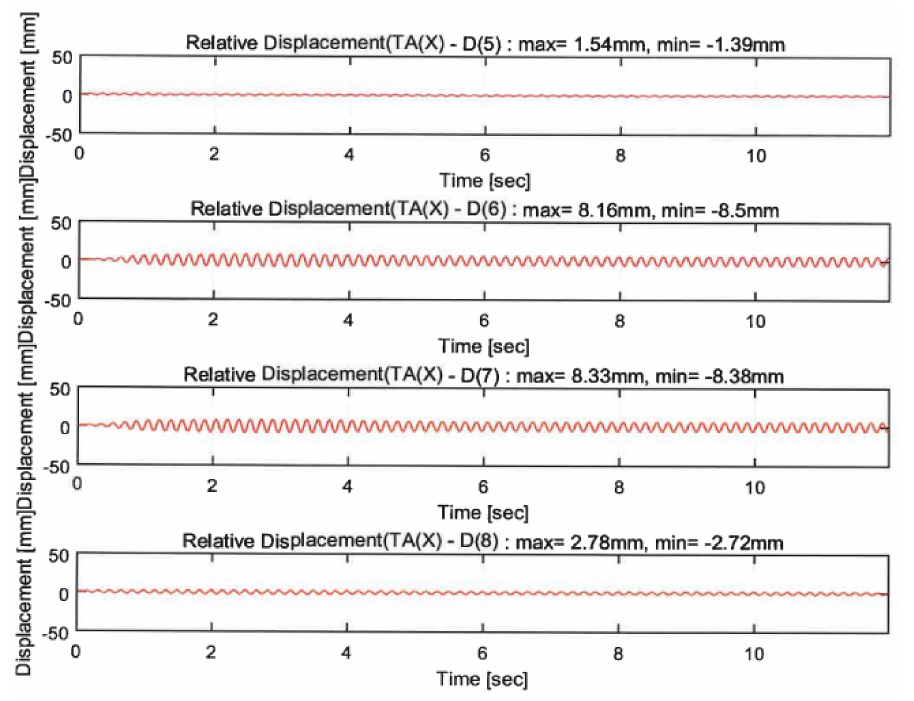
Figure 14. Dynamic responses under a sinusoidal wave of 6.0 Hz.